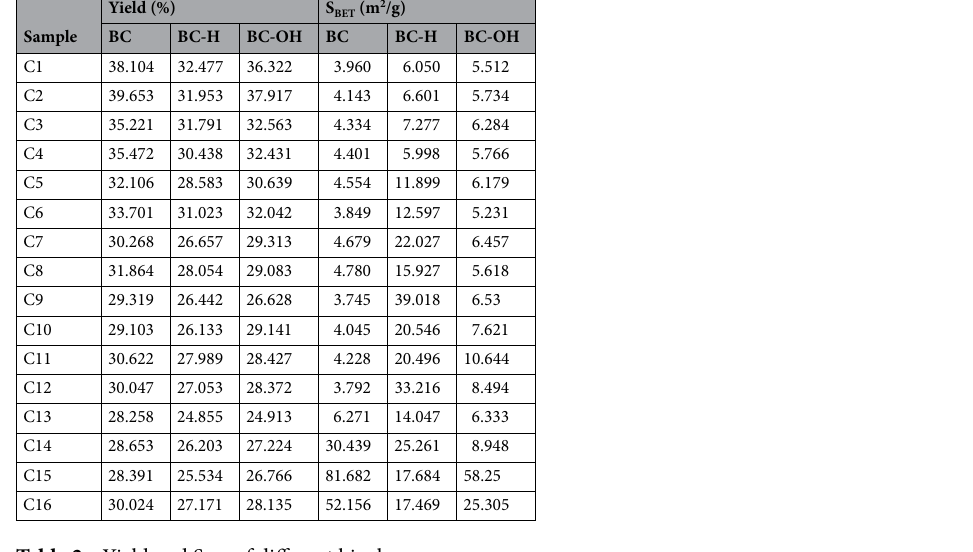
Table 2. Yield and S BET of different